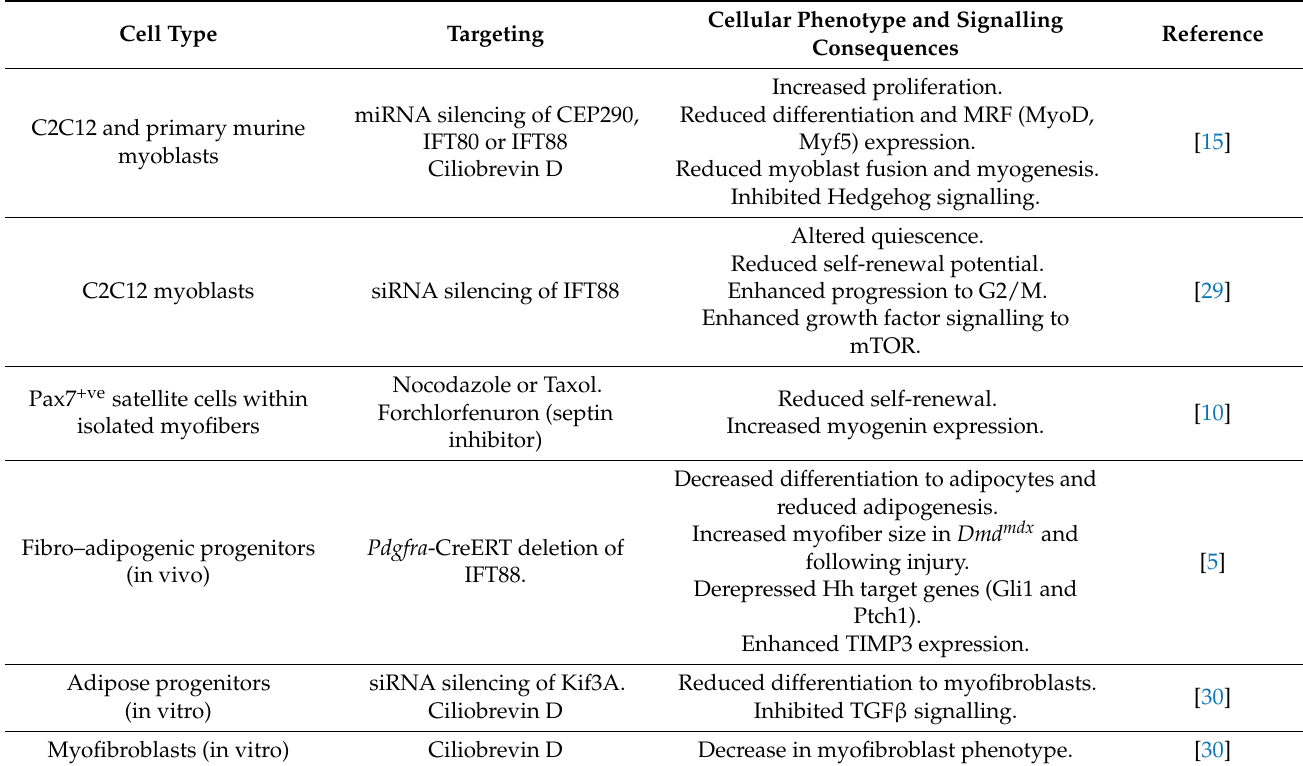
Table 1. Consequences of primary cilium ablation in skeletal muscle cell